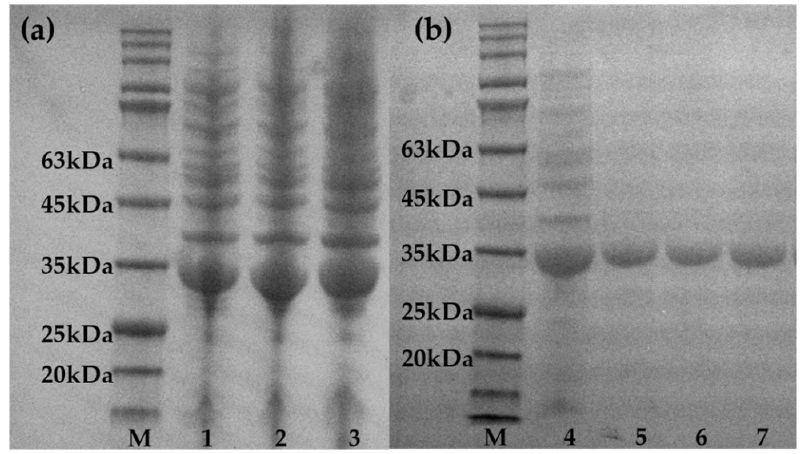
Figure 2. ( a ) SDS-PAGE electrophoresis results of WT, H92L/A138V, and E119V; the mutant has an over-expression band around 30 kDa similar to WT. Lane M: Protein Marker; Lane 1: WT; Lane 2: H92L/A138V; Lane 3: E119V; ( b ) Comparison of SDS-PAGE electrophoresis results before and after PPGMK purification. Lane M: Protein Marker; Lane 4: WT before purification; Lane 5: WT after purification; Lane 6: H92L/A138V after purification; Lane 7: E119V after purification.